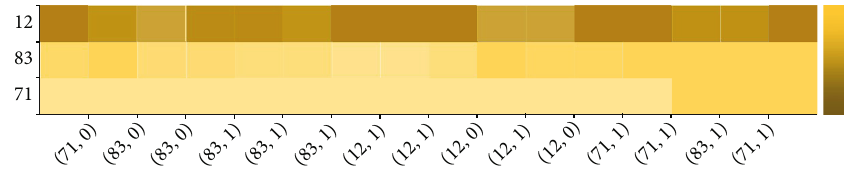
Figure 8: Heat map of sequence prediction